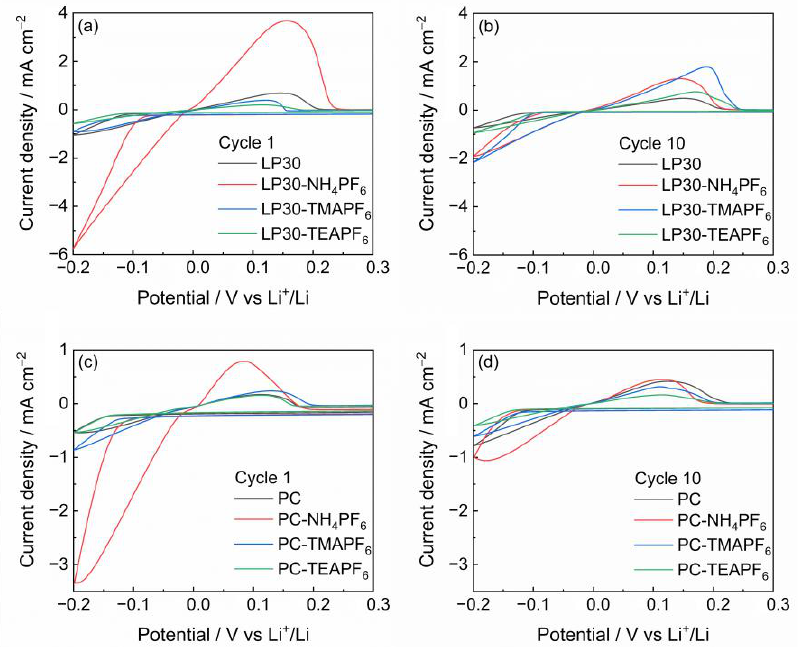
Figure 2. CVs at 20 mV s − 1 of ( a ) 1st CV, ( b ) 10th CV in LP30, and ( c ) 1st CV, ( d ) 10th CV in PC without and with the addition of 50 mM of NH 4 PF 6 , TMAPF 6 and TEAPF 6 .